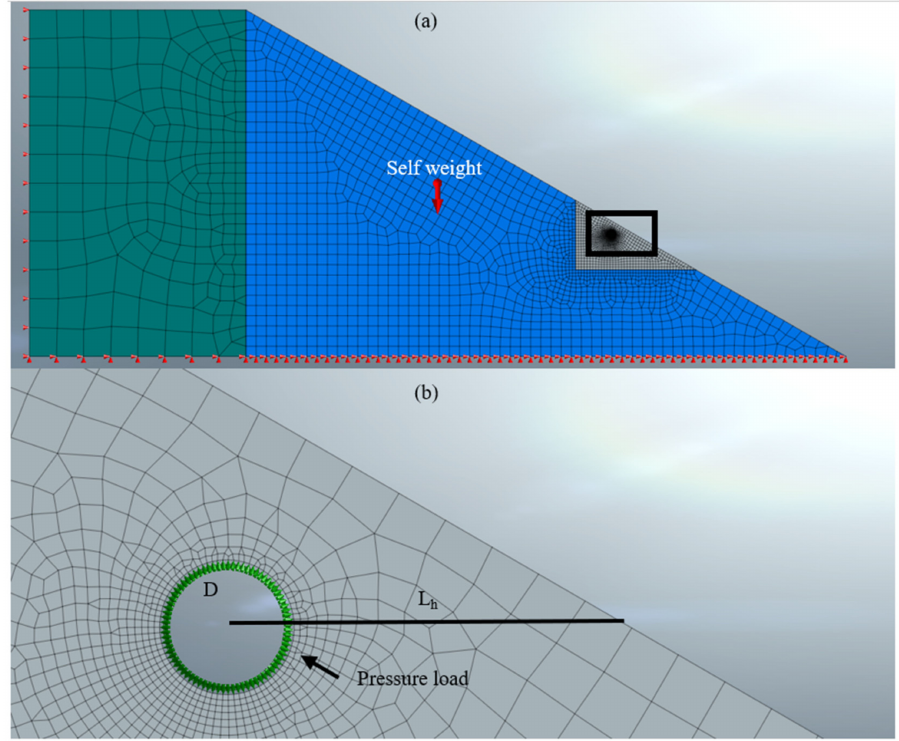
Figure 6. ( a ) Discretization and boundary conditions of the numerical global model; ( b ) enlargement of the area around the cavity and definition of the problem